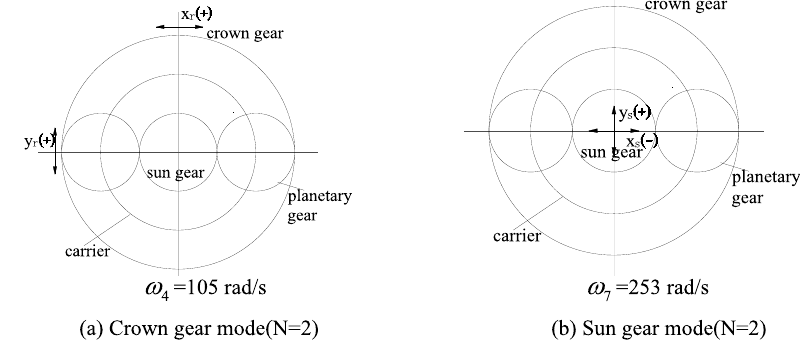
Fig. 9. (a) Crown gear mode ( N = 2); (b) Sun gear mode ( N =